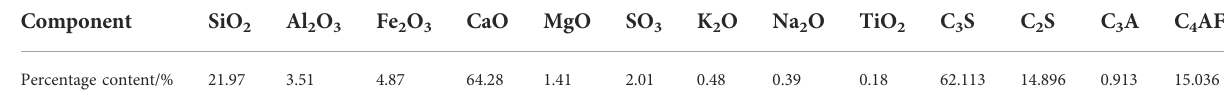
TABLE 2 Chemical composition and mineral composition of the Class G oil well